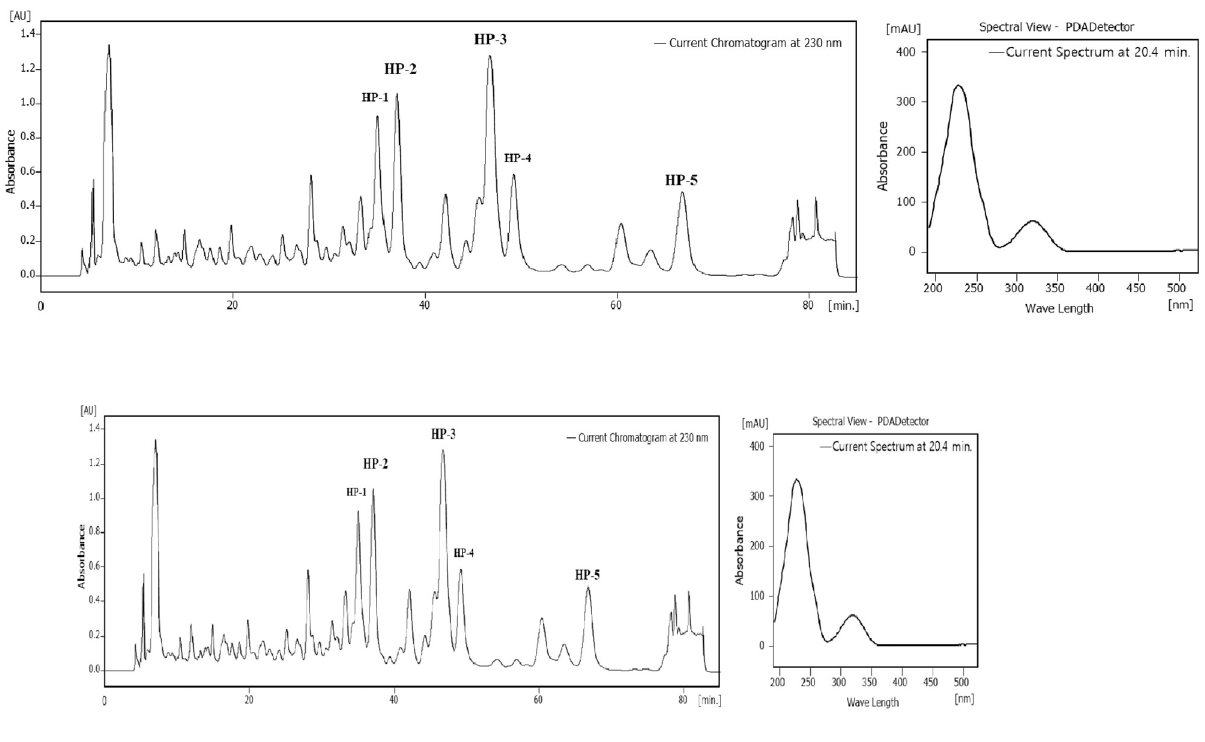
Fig 6. High-performance liquid chromatography chromatogram of compounds 1~5 produced by Streptomyces sp. KR0006 and UV spectrum. Column, waters Atlantis T3 column (i.d. 4.6x250 mm); mobile phase, 70% acetonitrile/0.02% TFA; flow rate, 0.8 ml/min; detection, 230nm.